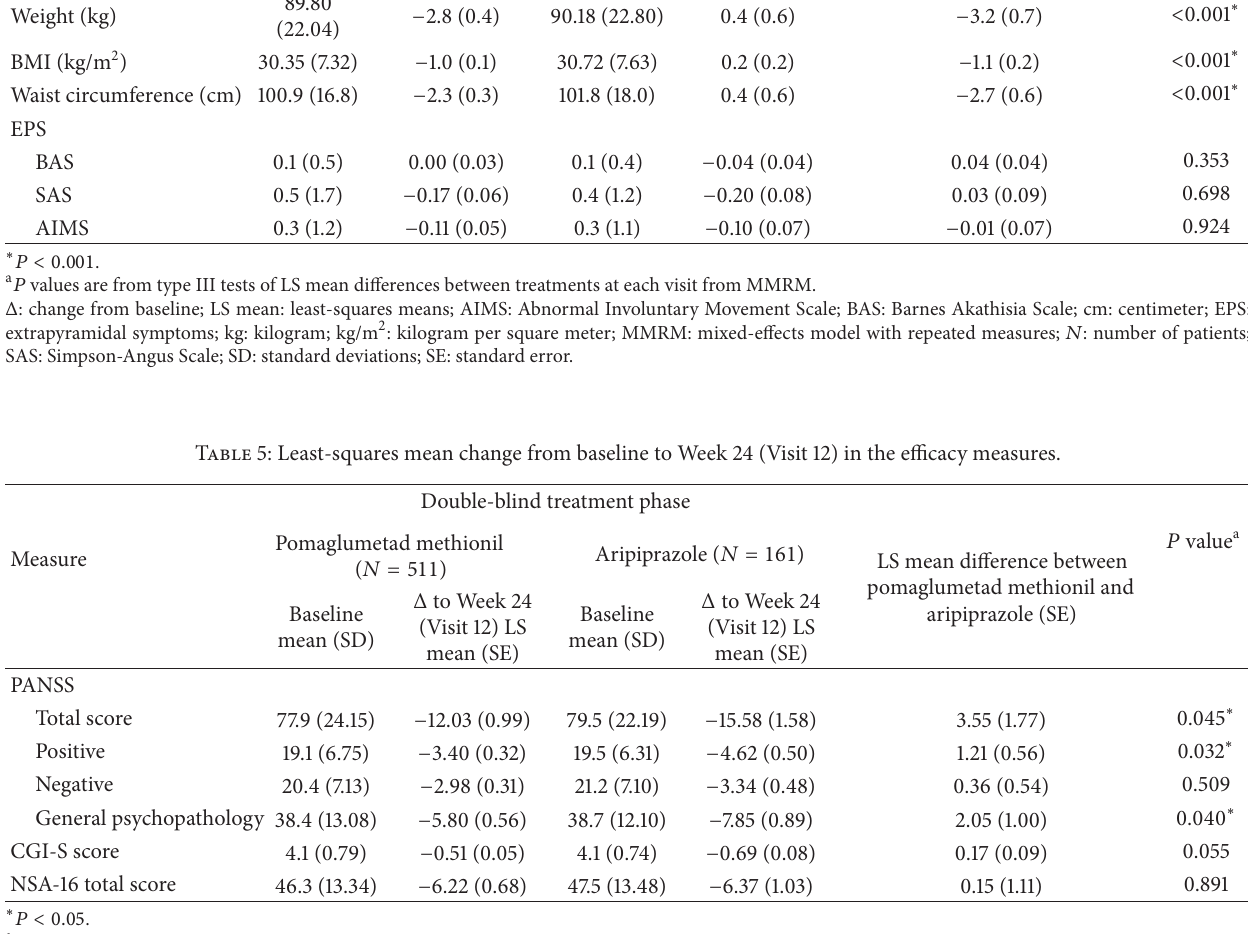
pomaglumetad methionil and aripiprazole (SE)Baseline Baseline